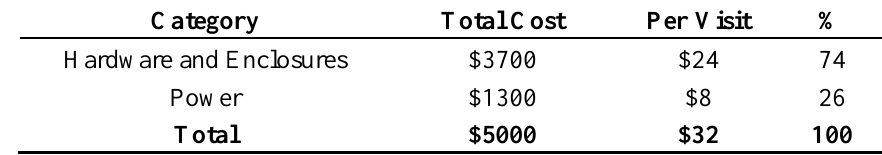
Table 9. Summary of cumulative maintenance cost and average cost per